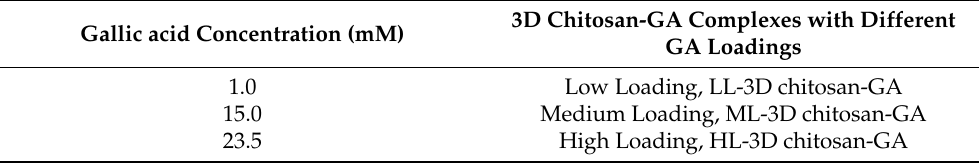
Table 1. 3D chitosan-GA complexes obtained by contacting 100 mg 3D chitosan samples with three different concentrations of